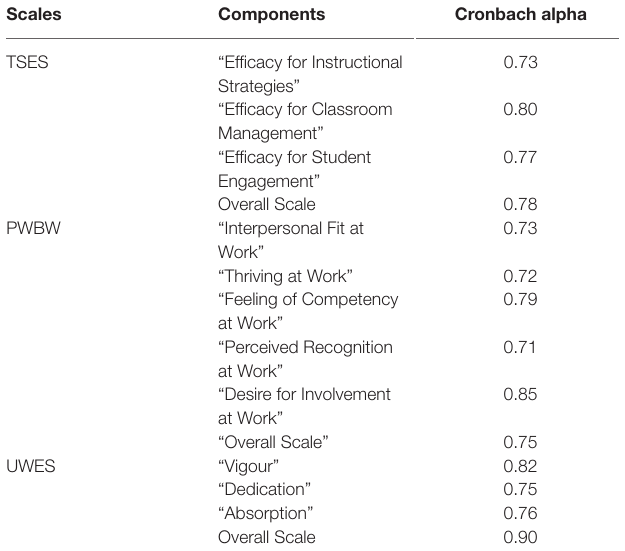
TABLE 5 | Goodness-of-fit indices.